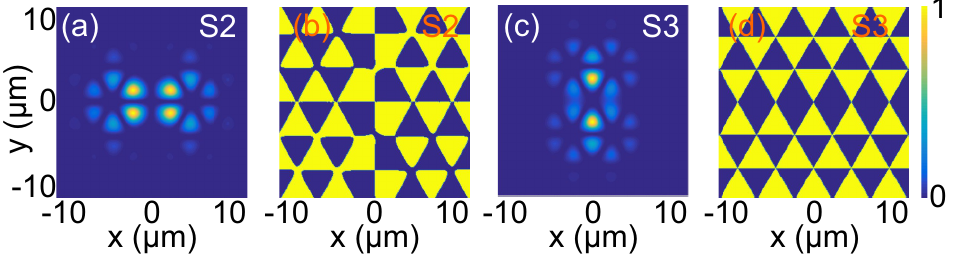
Figure 7: Analytically calculated real space intensity distribution (a),(c) and phase (b),(d) for the states S1 (a)-(b) and S3 (c)-(d). The phase is displayed in units of π